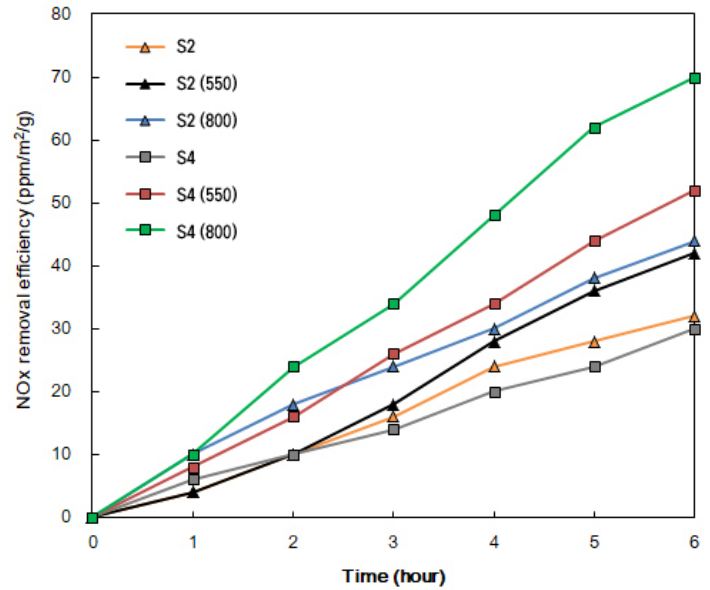
Figure 11. NO X removal efficiency under visible light irradiation.